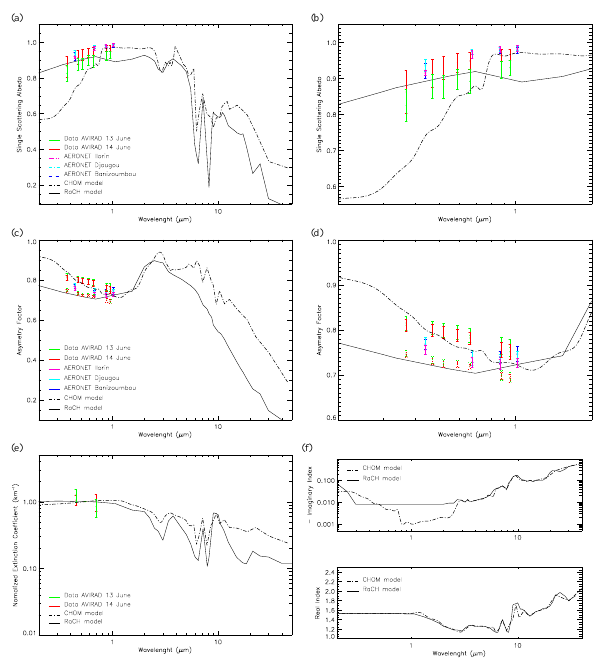
Fig.4. AerosolopticalpropertiesfromtheRaCHmodel(blacksolidline)andCHOMmodel(blackdashedline)asafunctionofwave- length: singlescatteringalbedo (a) ,asymetricfactor (c) ,extinctioncoefficientnormalizedat550nm (e) andrefractiveindex (f) usedfor Fig. 4. Aerosol optical properties from the RaCH model (black STREAMER.TheredandgreensymbolscorrespondtothemeasurementsmadebytheAVIRADaerosolsamplingdeviceduringthe13and 14June2006ATR-42flights. AERONETretrievalsareinpurple(Ilorin),lightblue(Djougou)anddarkblue(Banizoumbou). (b) asin(a) solid line) and CHOM model (black dashed line) as a function of butzoomedbetween0.2and2 µ m. (d) asin(c)butzoomedbetween0.2and2 µ m. wavelength: single scattering albedo (a) , asymetric factor (c) , ex- tinction coefficient normalized at 550nm (e) and refractive index (f) used for STREAMER. The red and green symbols correspond to the measurements made by the AVIRAD aerosol sampling de- vice during the 13 and 14 June 2006 ATR-42 flights. AERONET retrievals are in purple (Ilorin), light blue (Djougou) and dark blue (Banizoumbou). (b) as in (a) but zoomed between 0.2 and 2µm. (d) as in (c) but zoomed between 0.2 and